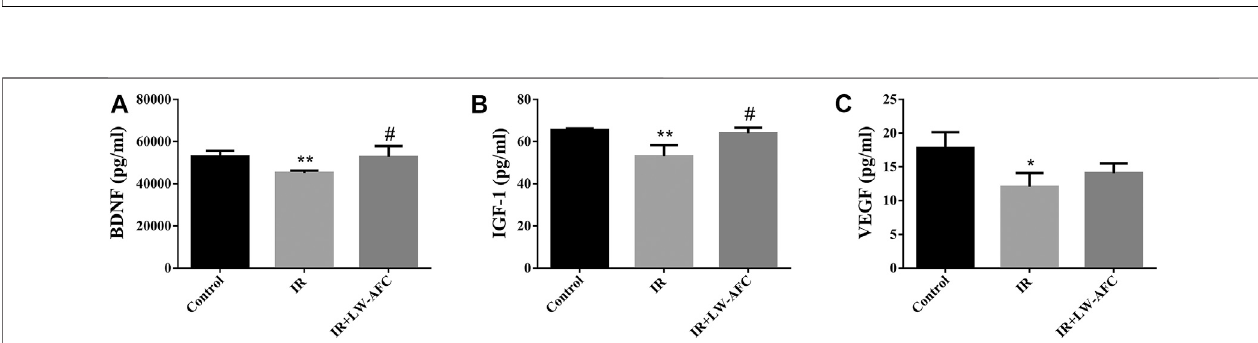
FIGURE 6 | LW-AFC reduces the oxidative stress level in the hippocampus of IR mice on day 1 after irradiation. Concentrations of (A) GSH, (B) GSH-Px, (C) CAT, (D) SOD,and (E) MDAweredetected.Thevaluesdenotemean ± S.D., n (cid:2) 6.* p < 0.05,** p < 0.01,and*** p < 0.001,versusthecontrolgroup; # p < 0.05, ## p < 0.01,and ### p < 0.001, versus the IR group. Abbreviation: IR, irradiation.